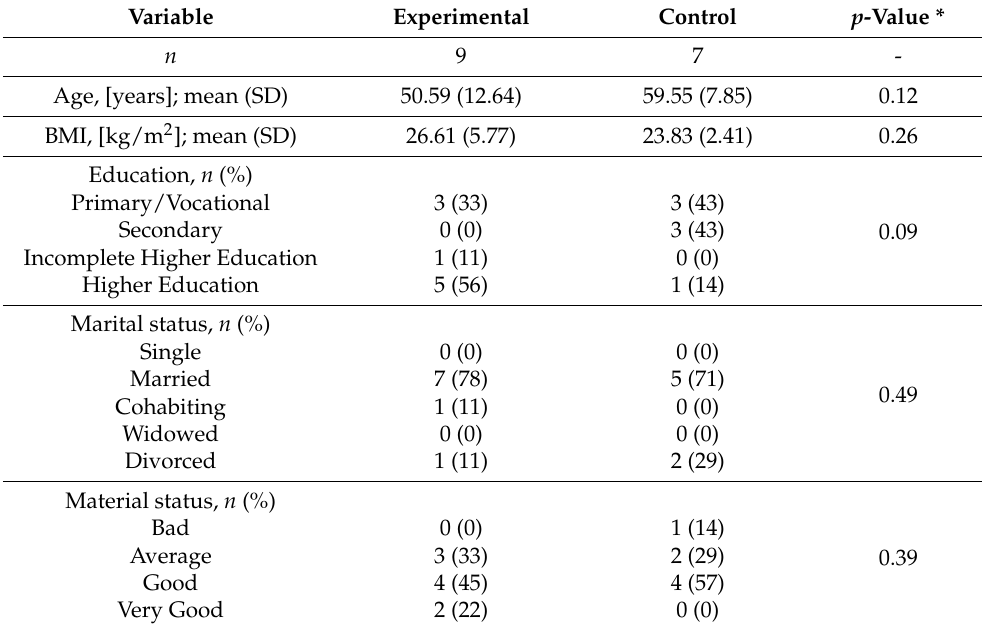
Table 1. Baseline demographic characteristics.